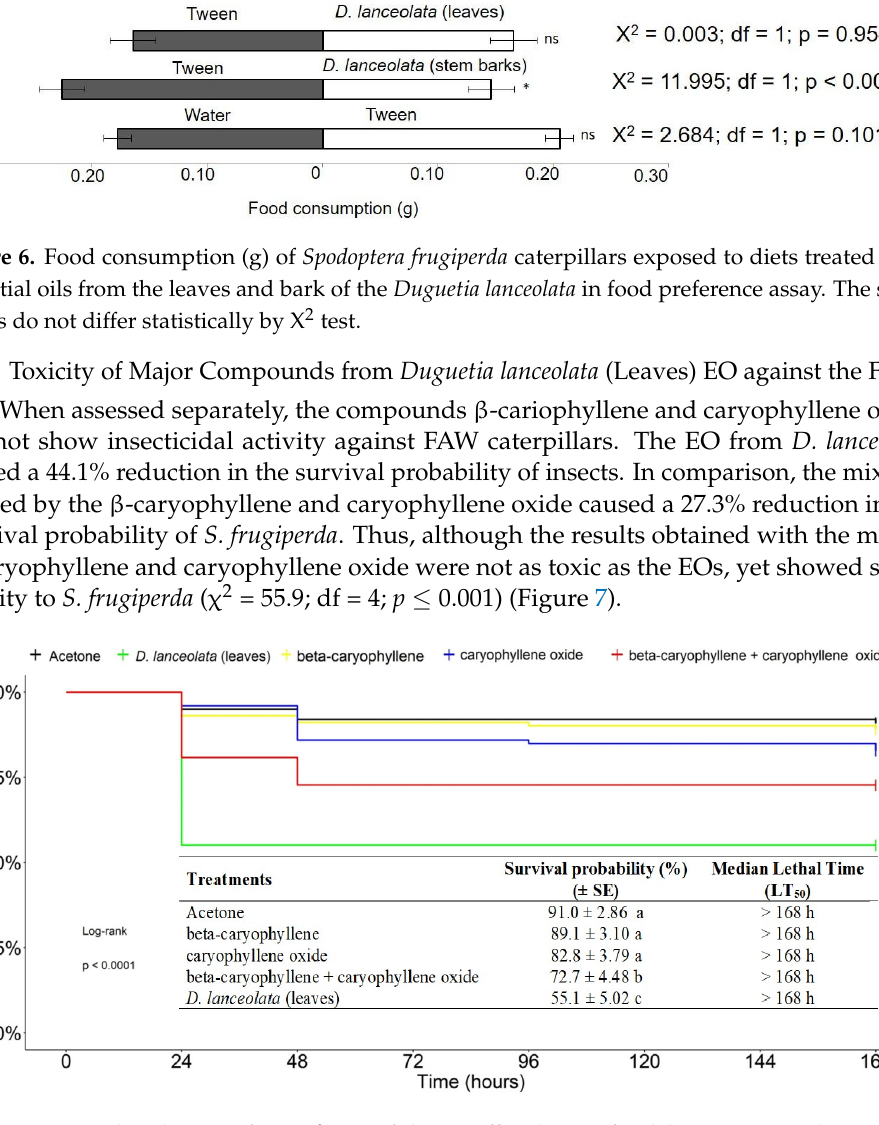
Figure 7. Survival analysis Spodoptera frugiperda larvae offered an artificial diet containing the essential oil of Duguetia lanceolata (leaves); β -caryophyllene; caryophyllene oxide; a mixture of β -caryophyllene and caryophyllene oxide; or the negative control: acetone. The same letters do not differ statistically by Pairwise multiple comparison test.